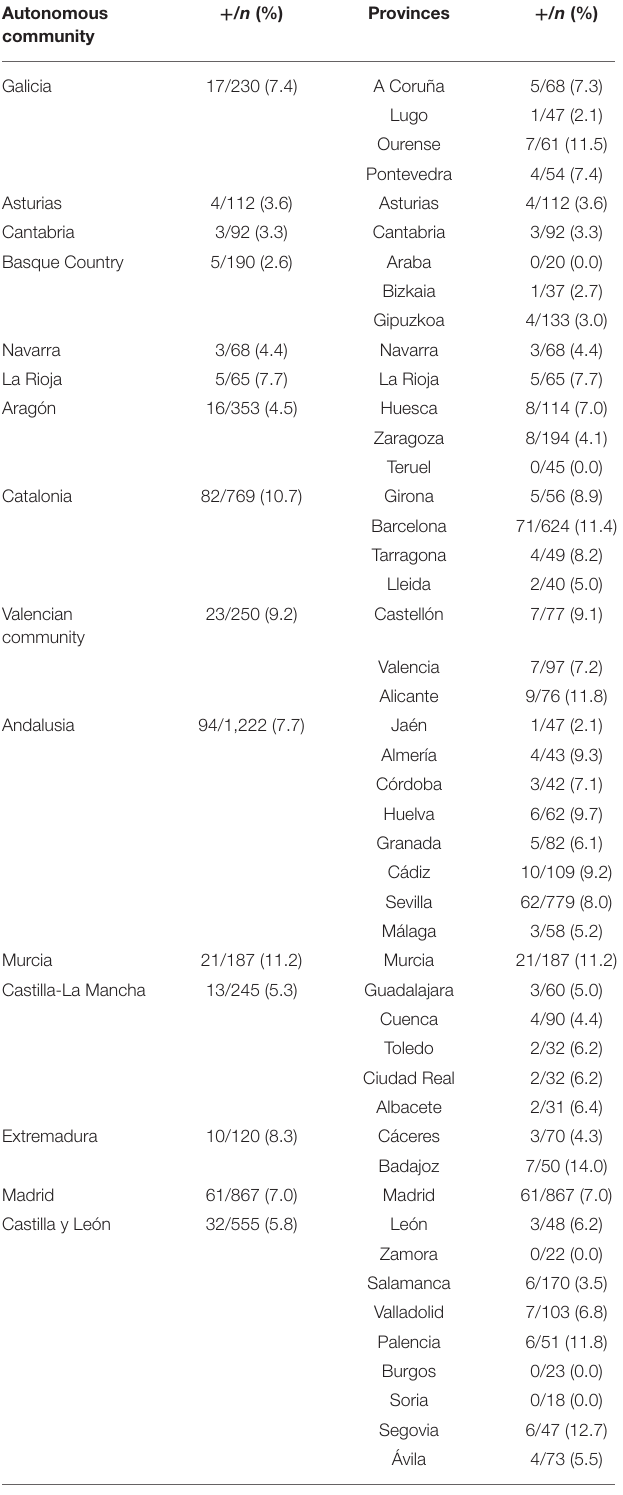
TABLE 1 | Distribution of seroprevalences for D. immitis in cats in Spain by autonomous communities, autonomous cities and provinces. Autonomous